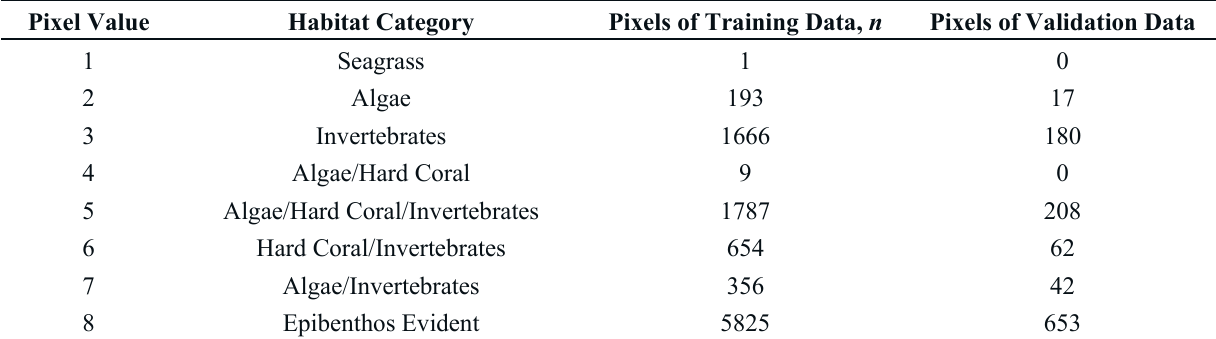
Table 3. Classification training and validation dataset from ground truthing survey. Note the small numbers associated with seagrass and algae/hard